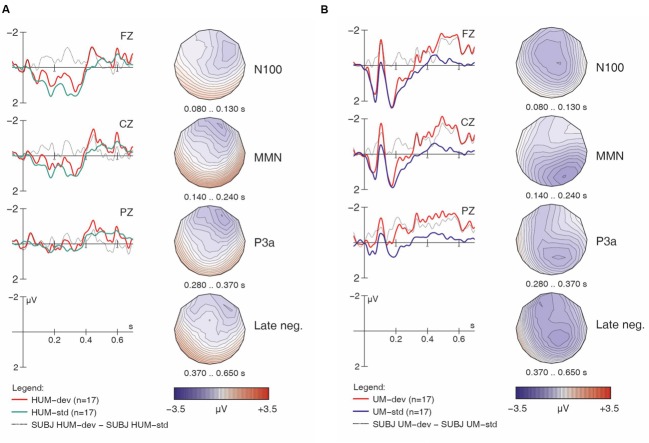
Learner responses to [hᴧm] (A) and [ᴧm] (B) items, both standards and deviants, with difference wave. Negativity is plotted upward; vertical axis at 0 ms indicates stimulus onset.